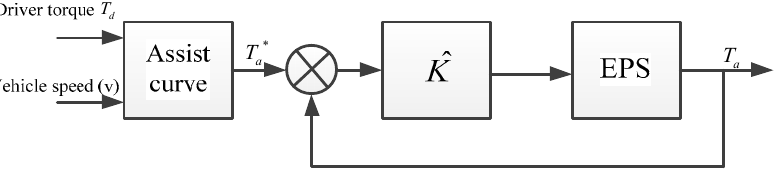
Figure 24. Desired loop gain.